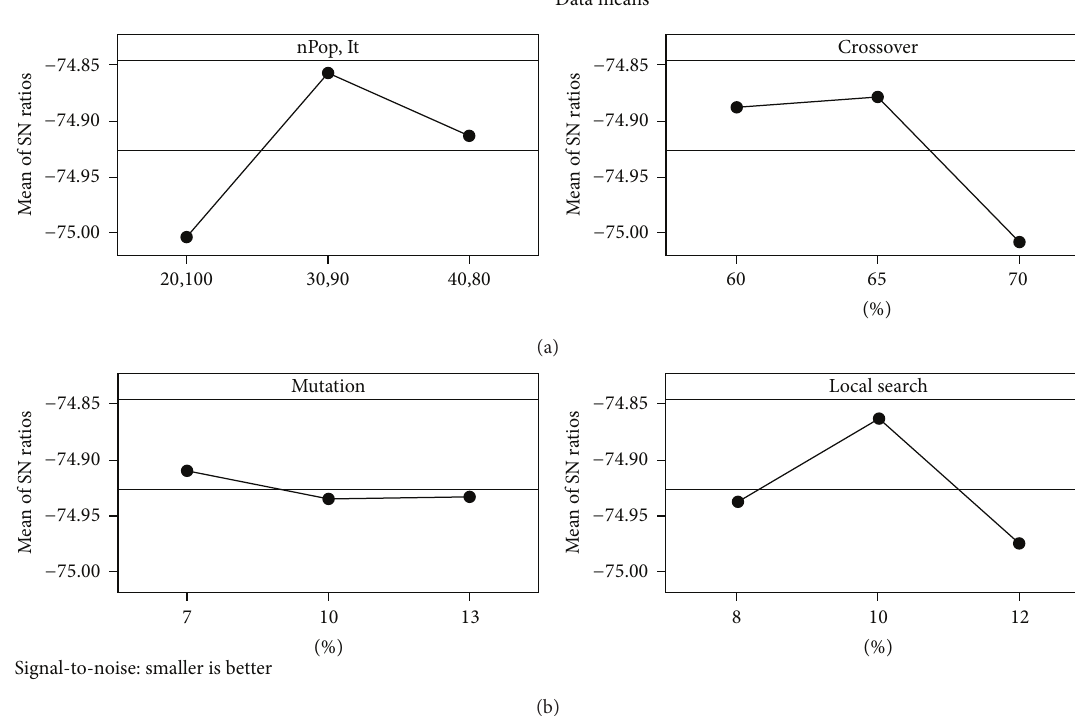
Figure 2: The mean S/N ratio plot for each level of the factors.